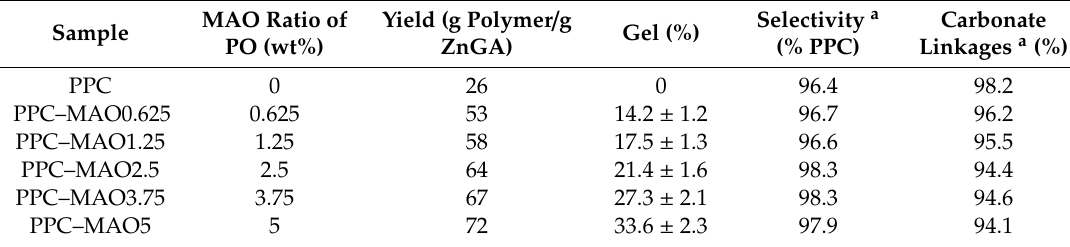
Scheme 1. The formation of polypropylene carbonate–maleic anhydride oligomers (PPC–MAOs) with networks in CO 2 / propylene oxide (PO) copolymerization in the presence of MAO. Table 1. The results of Table 1. The results of copolymerization.